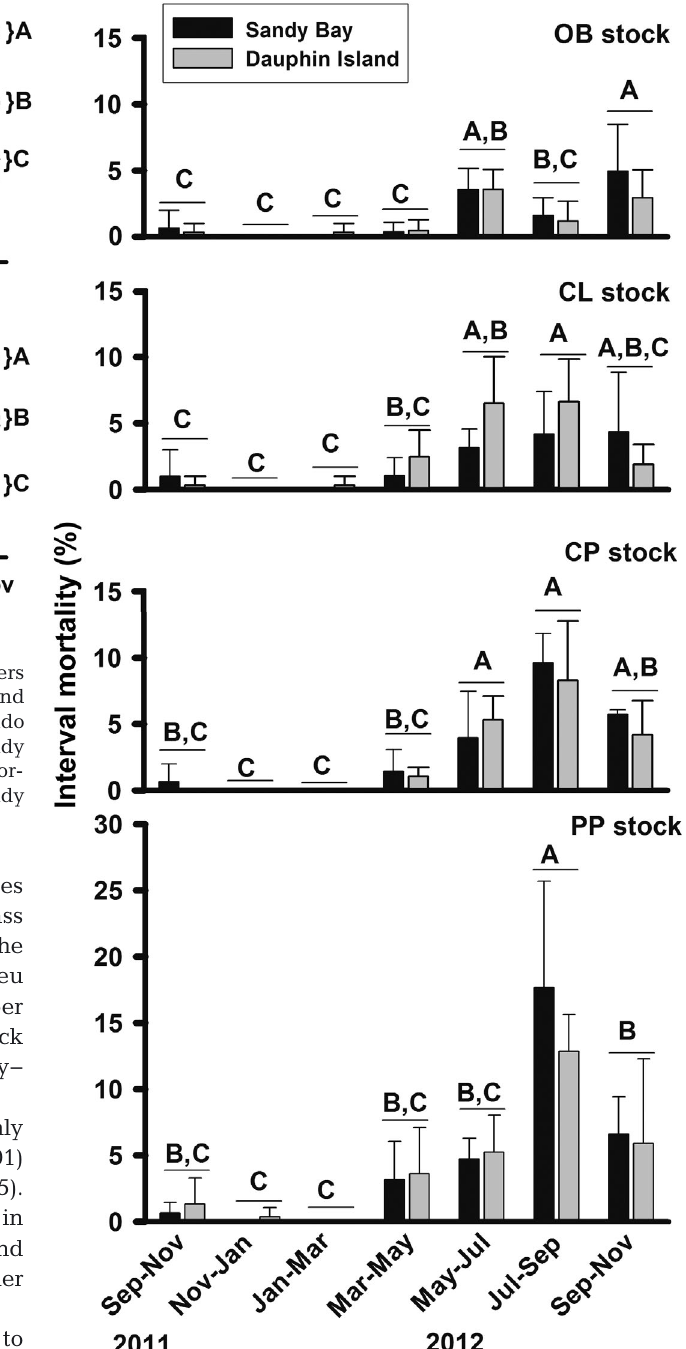
Fig. 5. Mean (±SD) interval mortality of Louisiana eastern oysters from the OBOY (OB) and Calcasieu Lake (CL) stocks, and Alabama oysters from the Cedar Point (CP) and Perdido Pass (PP) stocks at the Sandy Bay and Dauphin Island study sites. Interval mortality was significantly affected by sampling interval but not site. Groups that do not share let- ters have means that are sig nificantly different (p < 0.05). Lines over bars indicate that no significant differences in means could be shown between